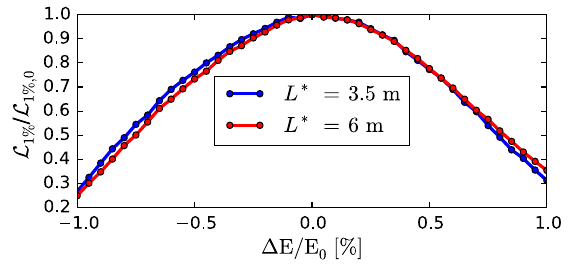
FIG. 8. Energy bandwidth comparison between L (cid:1) ¼ 3 . 5 m and L (cid:1) ¼ 6 m. L 1% is normalized to their respective maximum peak luminosity L 1% ; 0 .